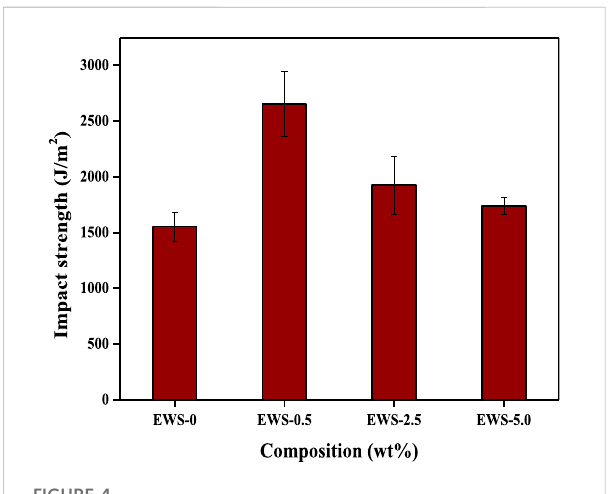
FIGURE 4 Izod impact strength of wool-epoxy-nanosilica composites.